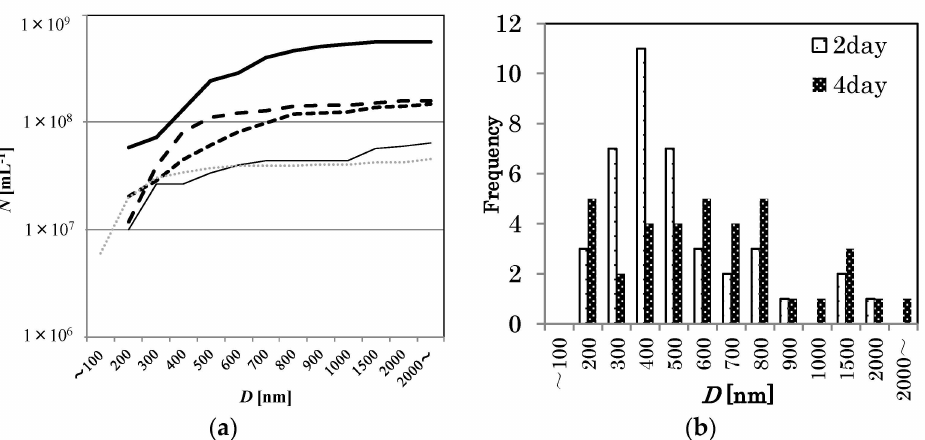
Figure 4. ( a ) Similar to Figure 3 except for 100 mM NaCl solution at various storage periods at 293 K (0 day: thick solid line, 2 days: larger dashed line, 4 days: smaller dashed line, 7 days: thin solid line, pure water: thin dotted line). ( b ) Apparent bubble diameter distributions in 100 mM NaCl solution 2 days after MNB generation (coarse dot bar, n = 40), and 4 days after MNB generation (fine dot bar, n = 36).